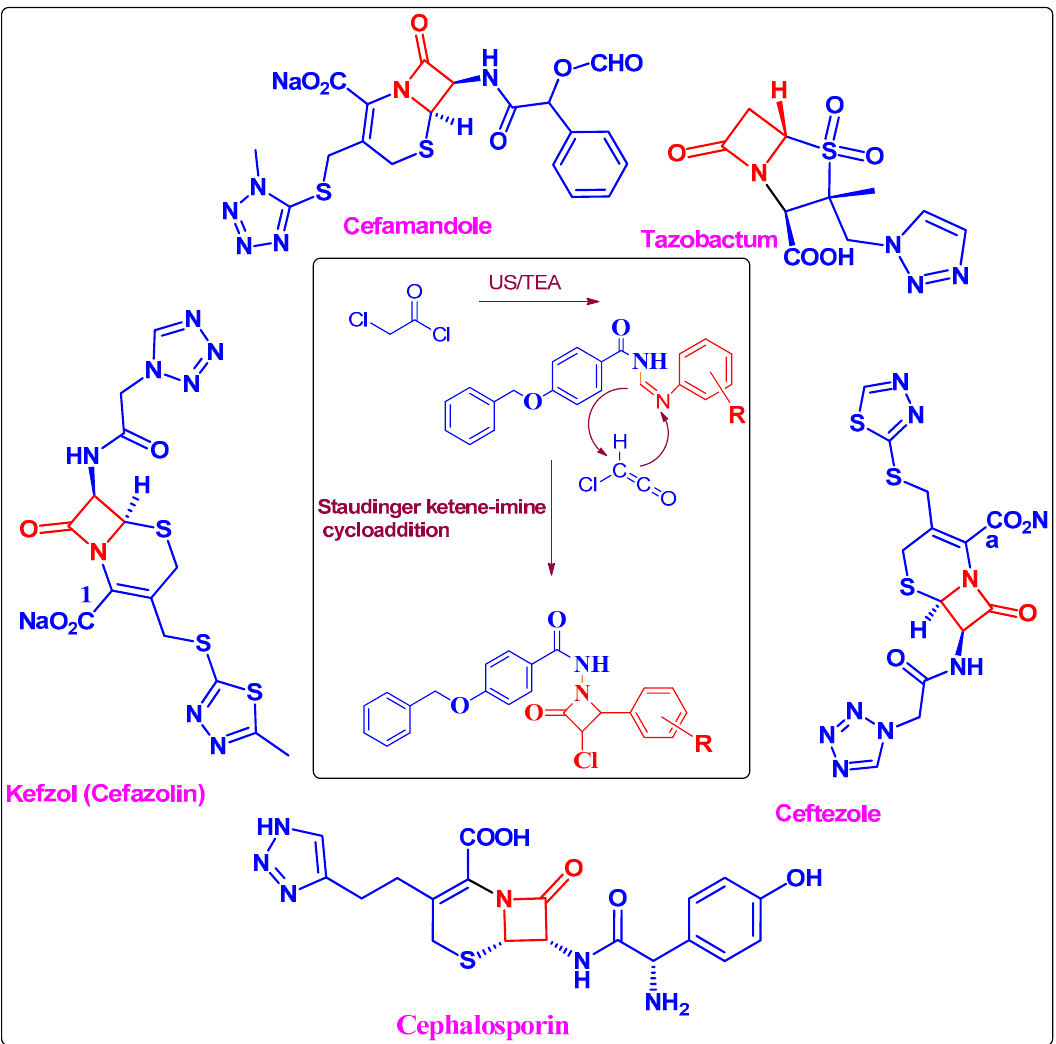
Figure 1. The design protocol for the synthesis of the target molecules.